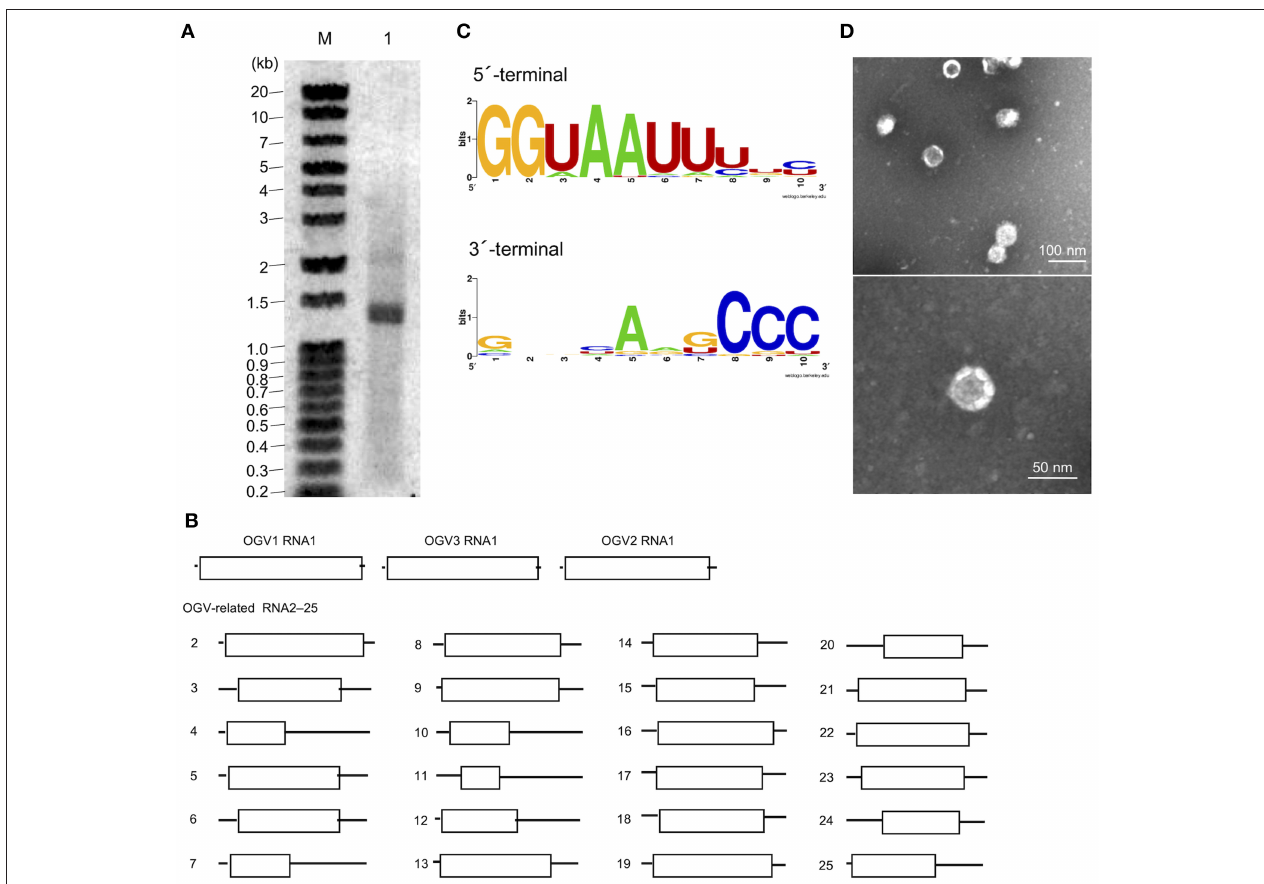
FIGURE 2 | Identification of Osugoroshi viruses (OGVs) in the Homona magnanima late strain. (A) dsRNA was isolated from the H. magnanima adult females of the late strain (lane 1) and separated by 1.5% agarose gel electrophoresis. The DNA marker was also shown (lane M). (B) The schematics of the identified OGVs’ RNA1 and other OGV-related RNAs. Boxes indicated the position of open reading frames (ORFs). (C) The consensus sequences of the first and the last ten nucleotides among the 27 identified OGV’s RNAs (in sense strands). (D) Electron microscopic image of viral particles purified from the adult female’s homogenate of the late strain. The particles were negatively stained, and the scale was indicated in each